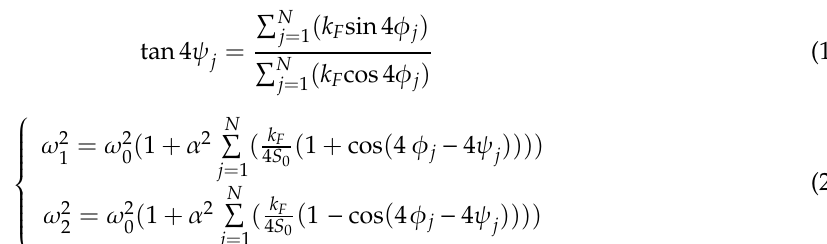
Figure 1. Ring with added radial springs.